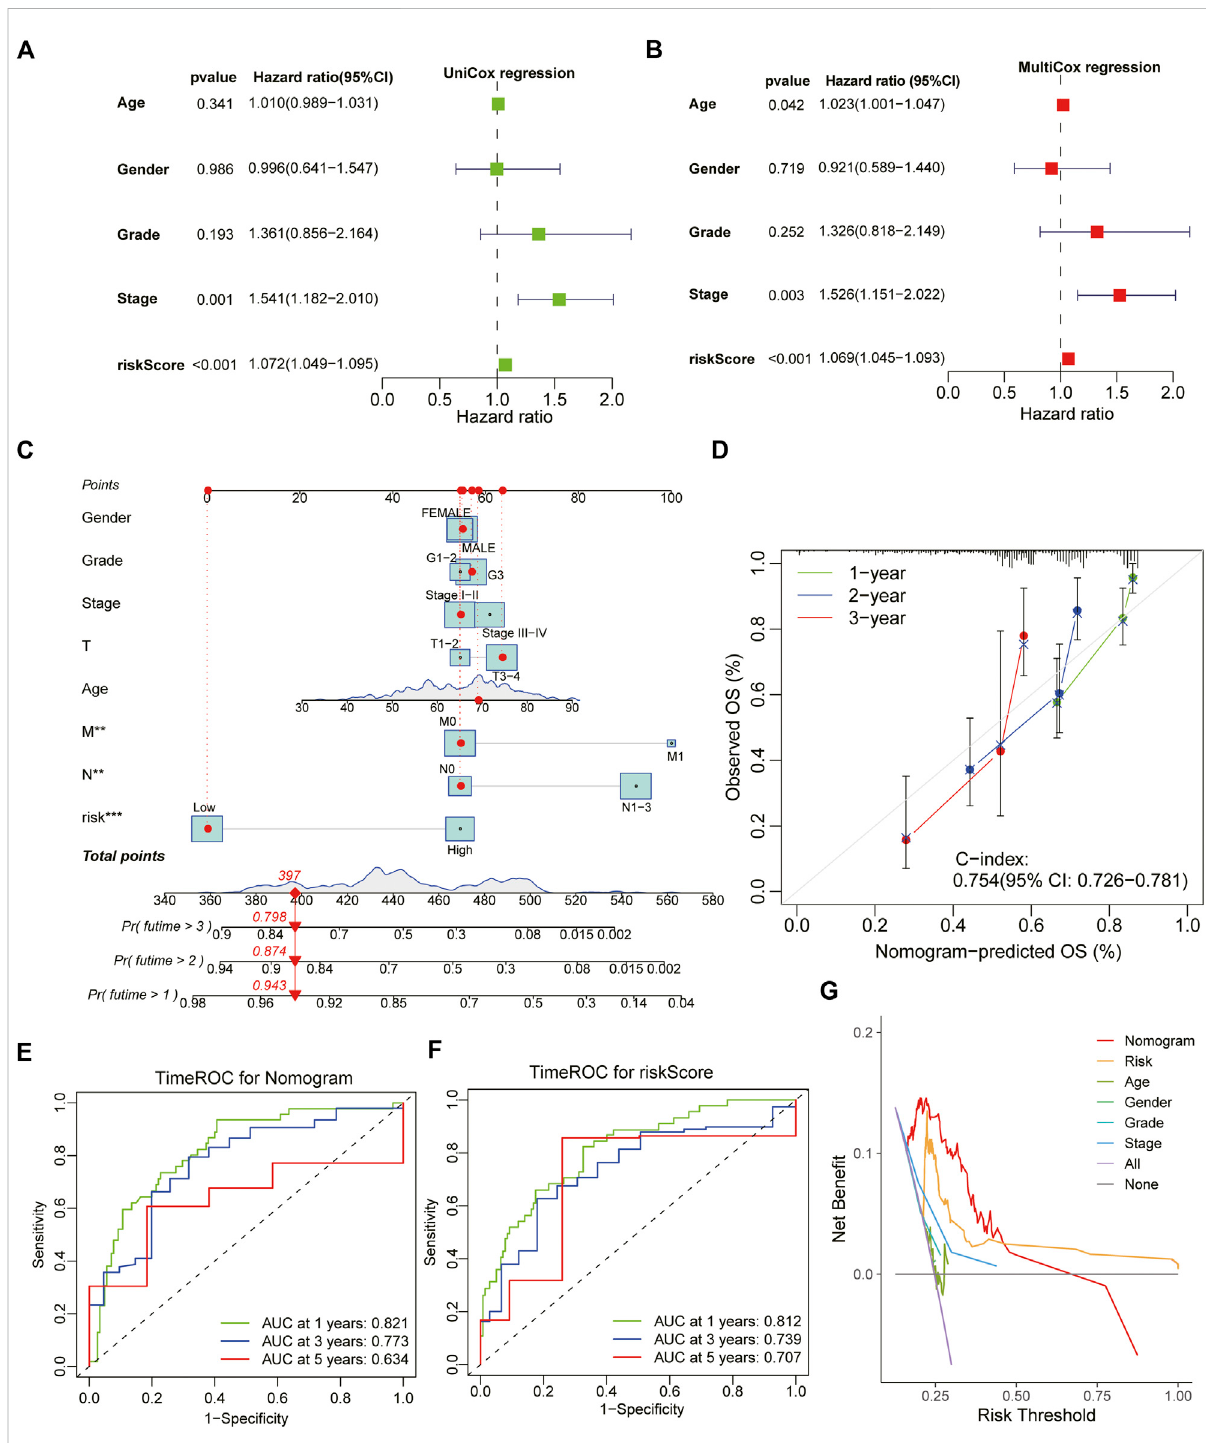
FIGURE 5 Construction and estimation of a combined prognostic model for STAD. (A,B) The forest chart showing the results of univariate Cox and multivariateCoxregressionanalysiswithclinicalcharacteristicsandATIRE-Riskscore. (C) Thecombinednomogramforpredictingtheindividual1/3/ 5-year survival ratio for STAD patients. (D) The calibration curve of above established nomogram with C-index and 1/3/5-year survival ratio respectively. (E,F) Time-dependentROCanalysisof1/3/5-yearssurvivalassessmentsforSTADpatientsusingthenomogram modelandATIRE- Risk scores respectively. (G) The DCA analysis demonstrated the more signi fi cant role of Risk scores than other parameters in the nomogram model for GC